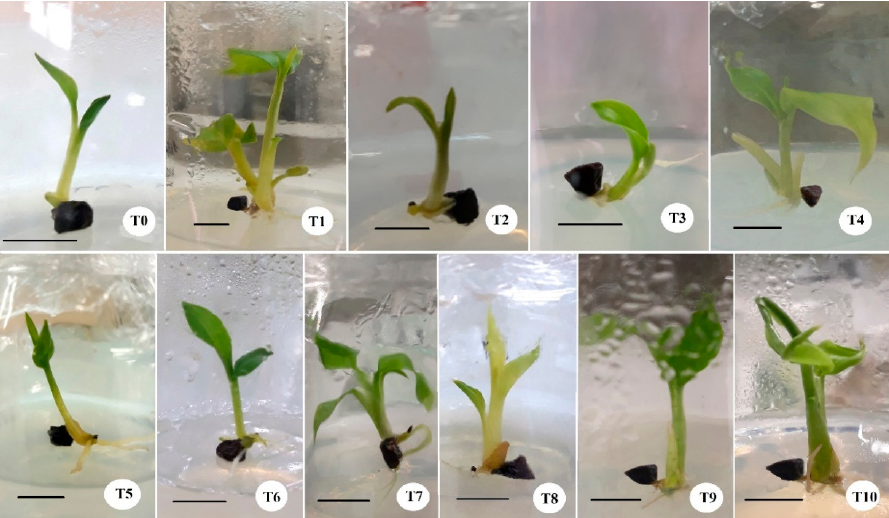
Figure 4. In vitro black cardamom seed germination patterns under different treatments.